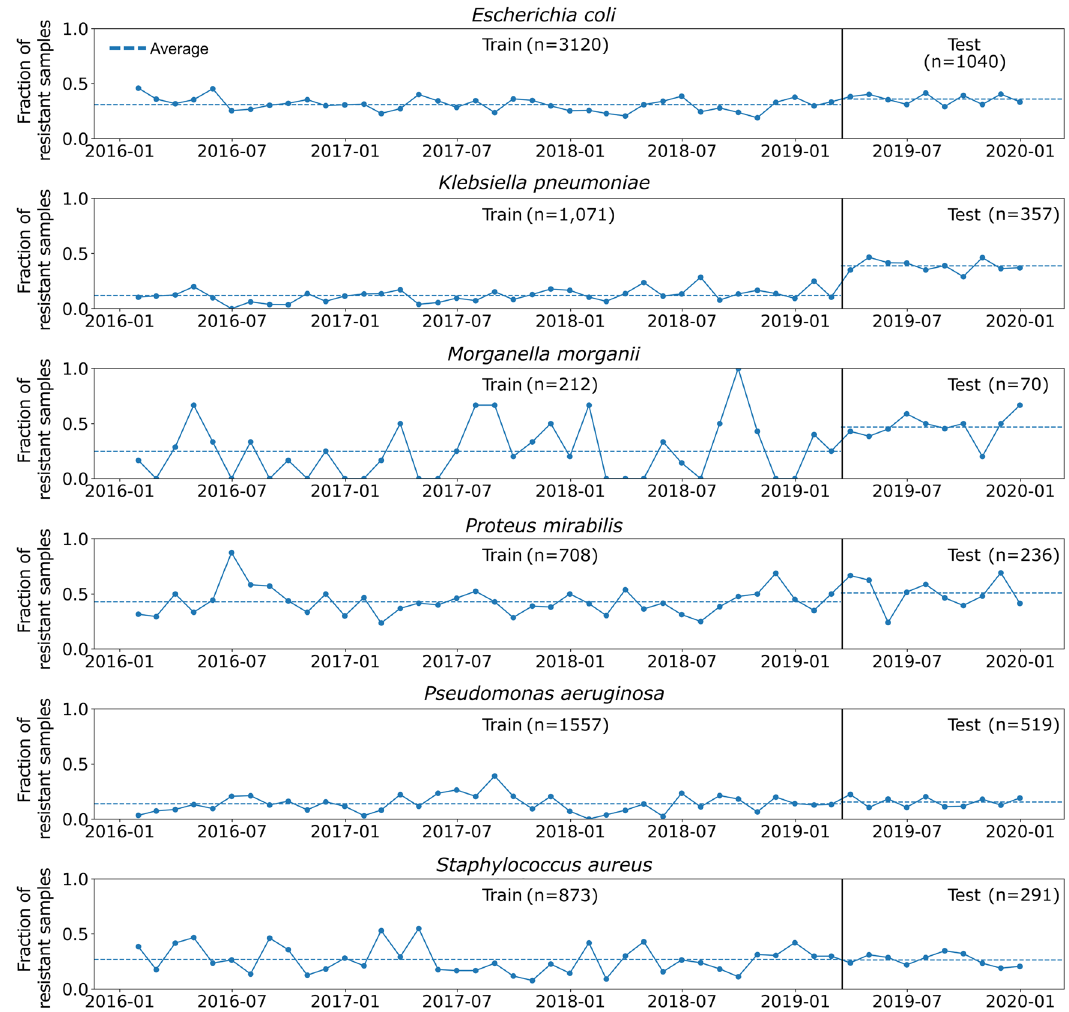
Fig. 1 Cipro fl oxacin resistance time-trends strati fi ed by bacterial species. Points connected by solid lines are the average monthly cipro fl oxacin resistance frequencies. The dotted horizontal lines represent the average resistance in the training and test sets, which are separated by the black vertical